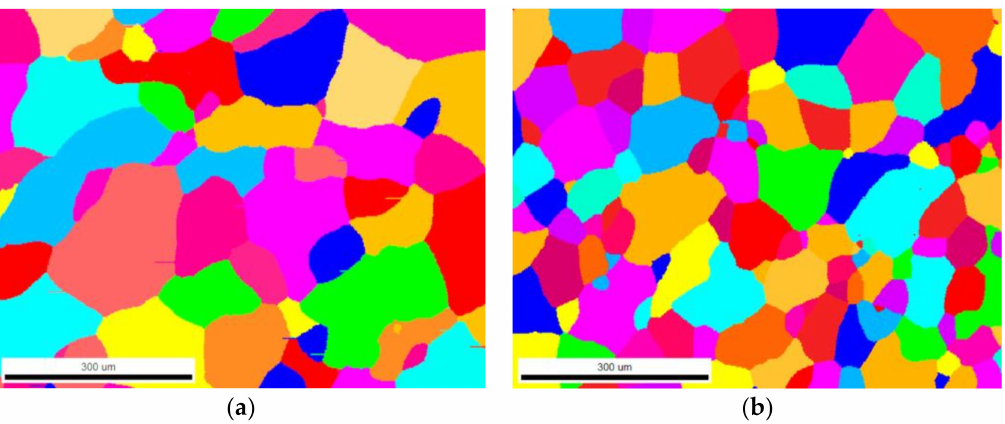
Figure 14. Grain structure derived by electron backscatter di ff raction (EBSD): ( a ) 2.9 mm thickness sample and ( b ) 3.2 mm thickness sample. The grain structure was finer in 3.2 mm sample in the middle of the section, but also on the surface region.